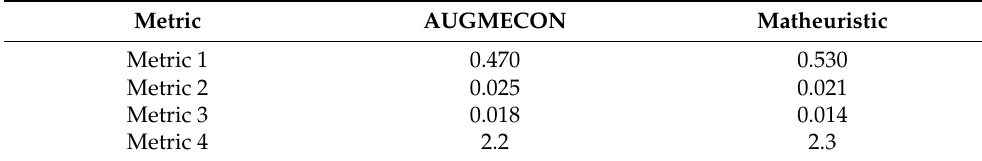
Table 1. Performance metrics for the AUGMECON and matheuristic